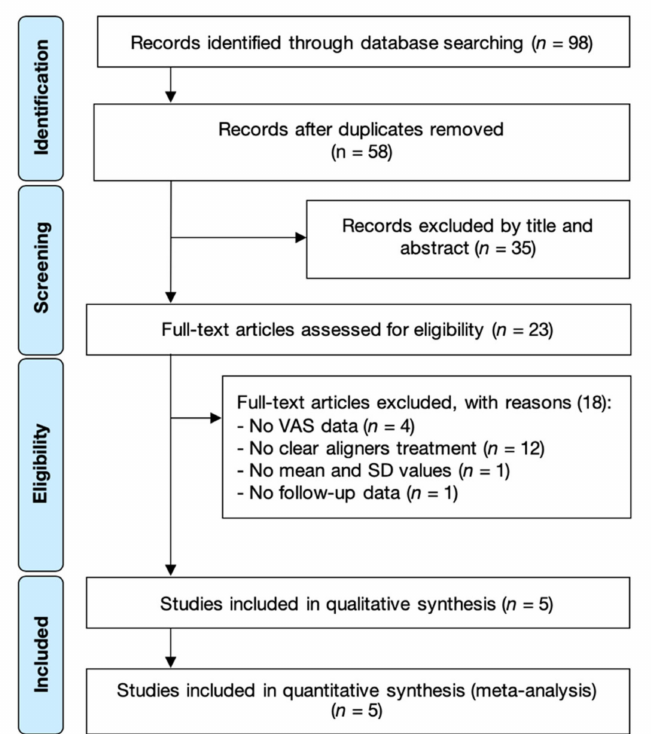
Figure 1. PRISMA (preferred reporting items for systematic reviews and meta-analyses)